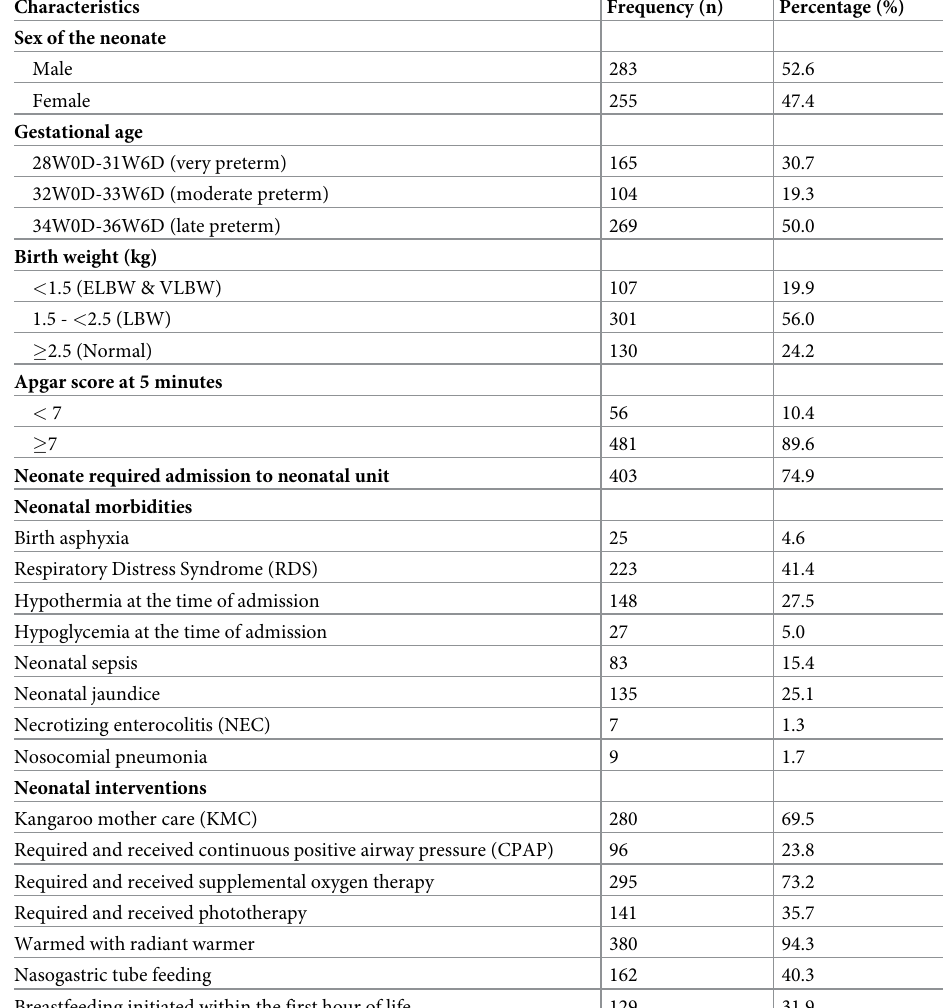
Table 3. Characteristics of preterm neonates born at Mbarara Regional Referral Hospital from October 2019 to September 2020 (N =